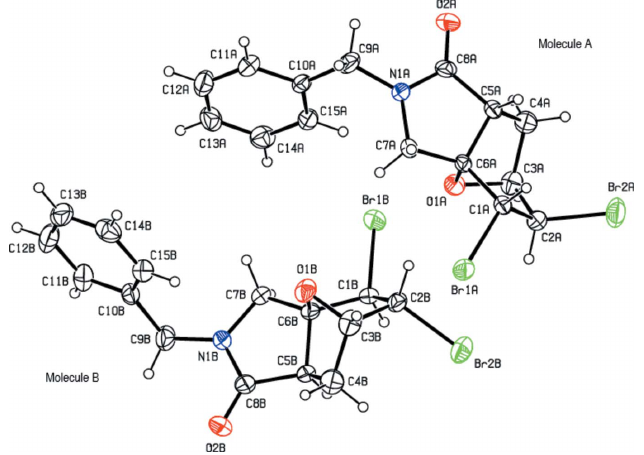
Figure 2 The two molecules ( A and B ) in the asymmetric unit of the title compound with displacement ellipsoids for the non-hydrogen atoms drawn at the 30% probability level.